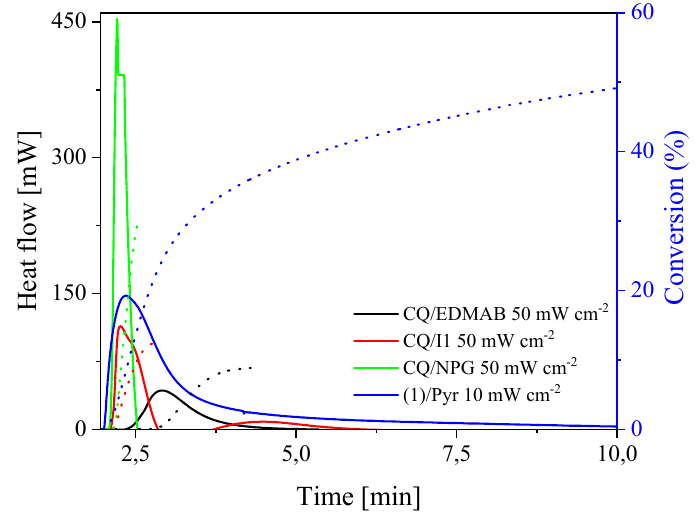
Figure 9. Comparison of TMPTA polymerization initiated by systems: (black) camphorquinone (1 × 10 − 3 M)/ethyl-4-dimethylaminobenzoate (1 × 10 − 2 M), light intensity 50 mW cm − 2 , (red) camphorquinone (1 × 10 − 3 M)/diphenyliodonium chloride (1 × 10 − 2 M), light intensity 50 mW cm − 2 , (green) camphorquinone (1 × 10 − 3 M)/ N -phenylglycine (1 × 10 − 2 M), light intensity 50 mW cm − 2 , BODIPY dye (1) (1 × 10 − 3 M)/ N -methoxy-4-phenylpyridinium tetrafluoroborate (5 × 10 − 2 M), light intensity 10 mW cm − 2 (solid line denotes data of rate of polymerization; dash line - conversion of monomer).